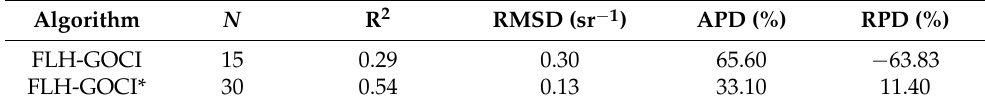
Figure 8. Scatter plot of measured data and calculated FLH results (FLH-GOCI: FLH result calculated by using the GOCI original band; FLH-GOCI*: FLH algorithm result of GOCI in this study). Table 4. Results of FLH algorithm performance validated using the measured datasets.